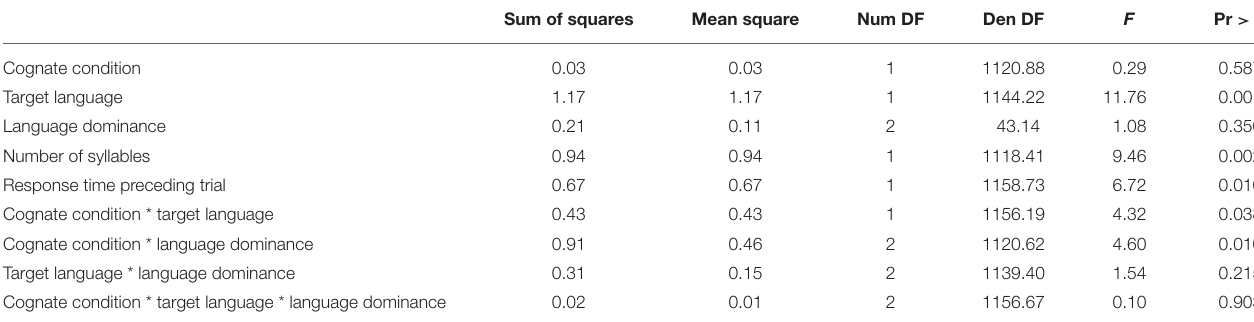
TABLE 1 | Results of the best-fitting linear mixed effects model predicting log response times for Cognates vs. Controls. Sum of squares Mean square Num DF Den DF F Pr > F